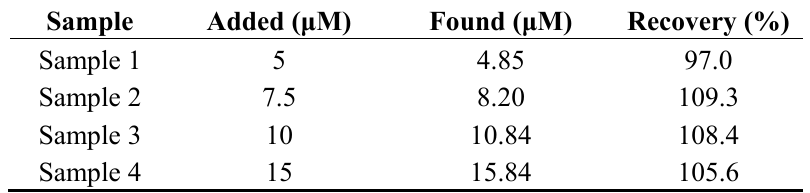
Table 2. Determination results of NP in PVC water bottle